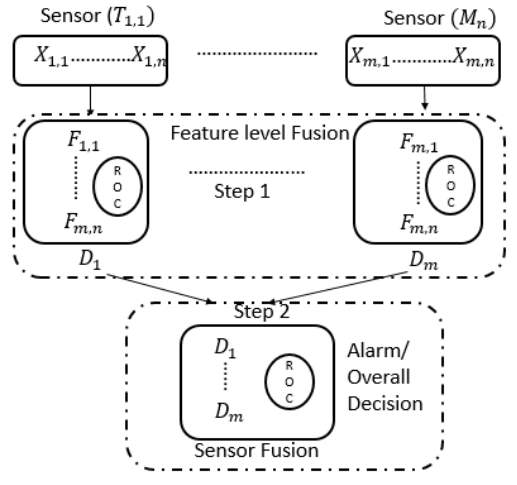
Figure 10. Two-step feature-based sensor fusion model.